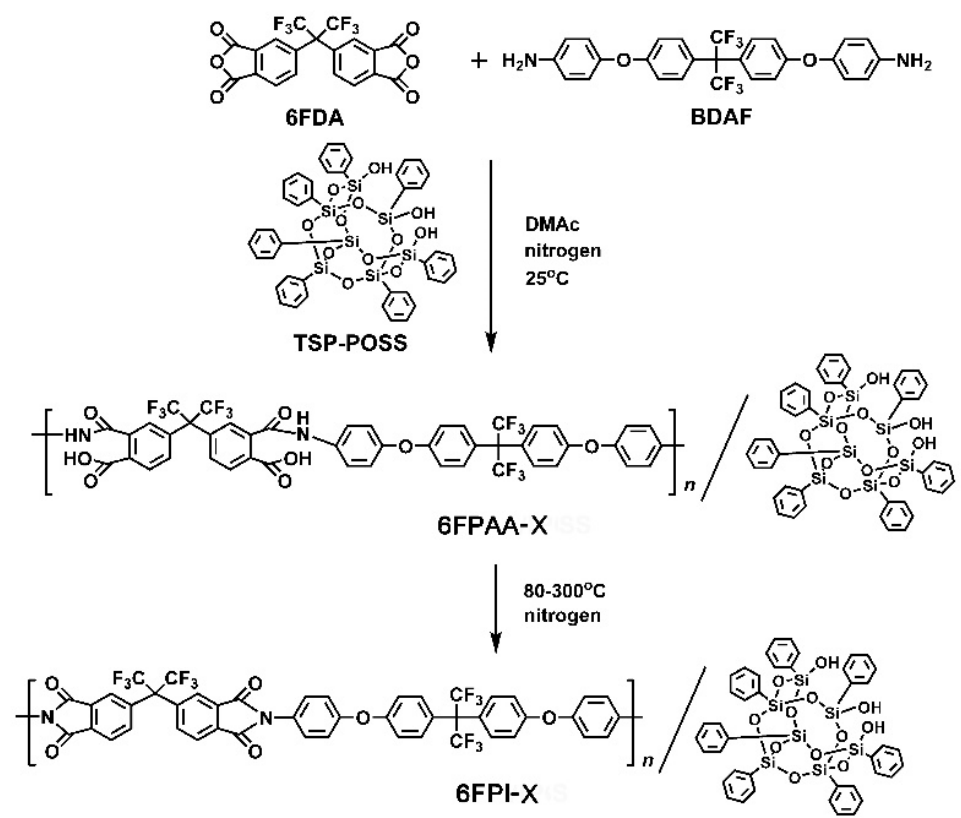
Figure 2. Synthesis of 6FPAA-X solutions and preparation of 6FPI-X composite films.